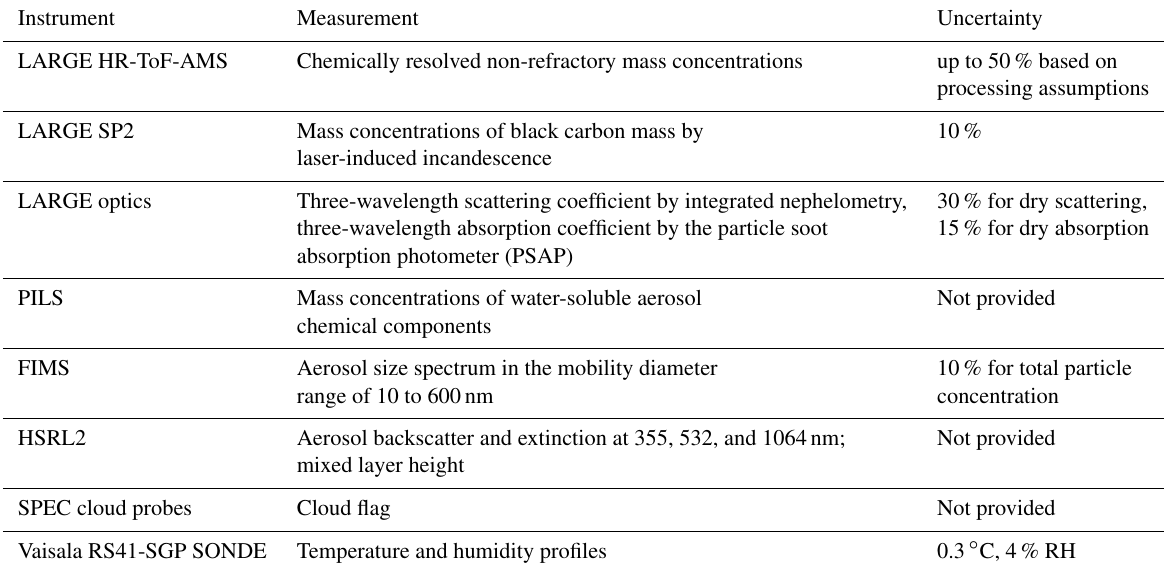
Table 1. Observational data used in this study along with their uncertainty.